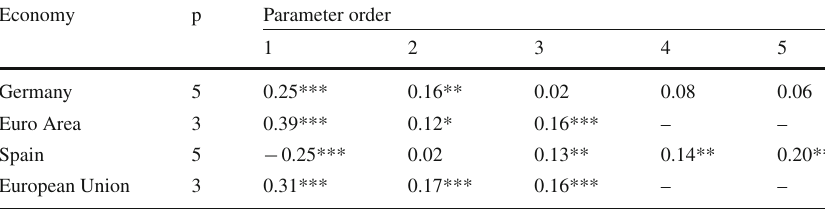
Table 3 Selected linear AR models. Source: author’s calculations Economy